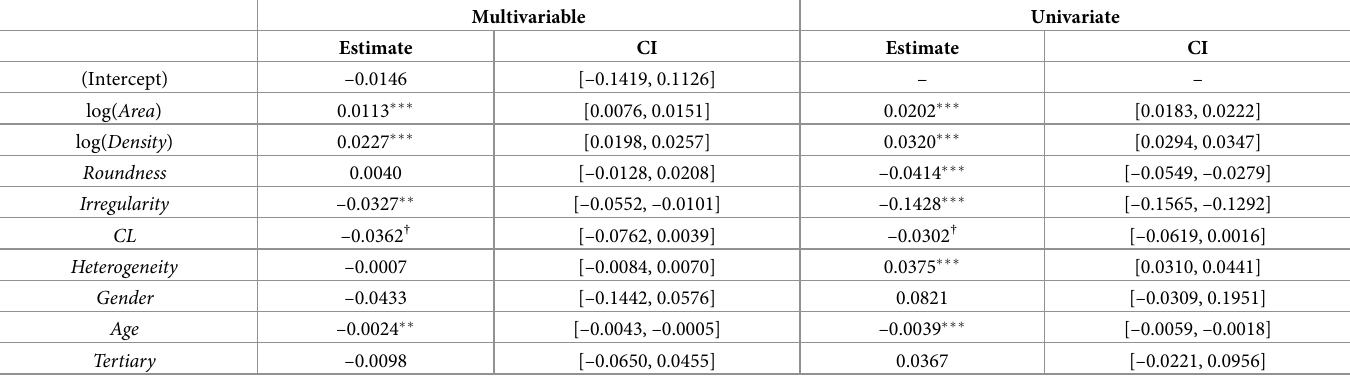
Table 5. Coefficients of multivariate and univariate negative binomial regressions.